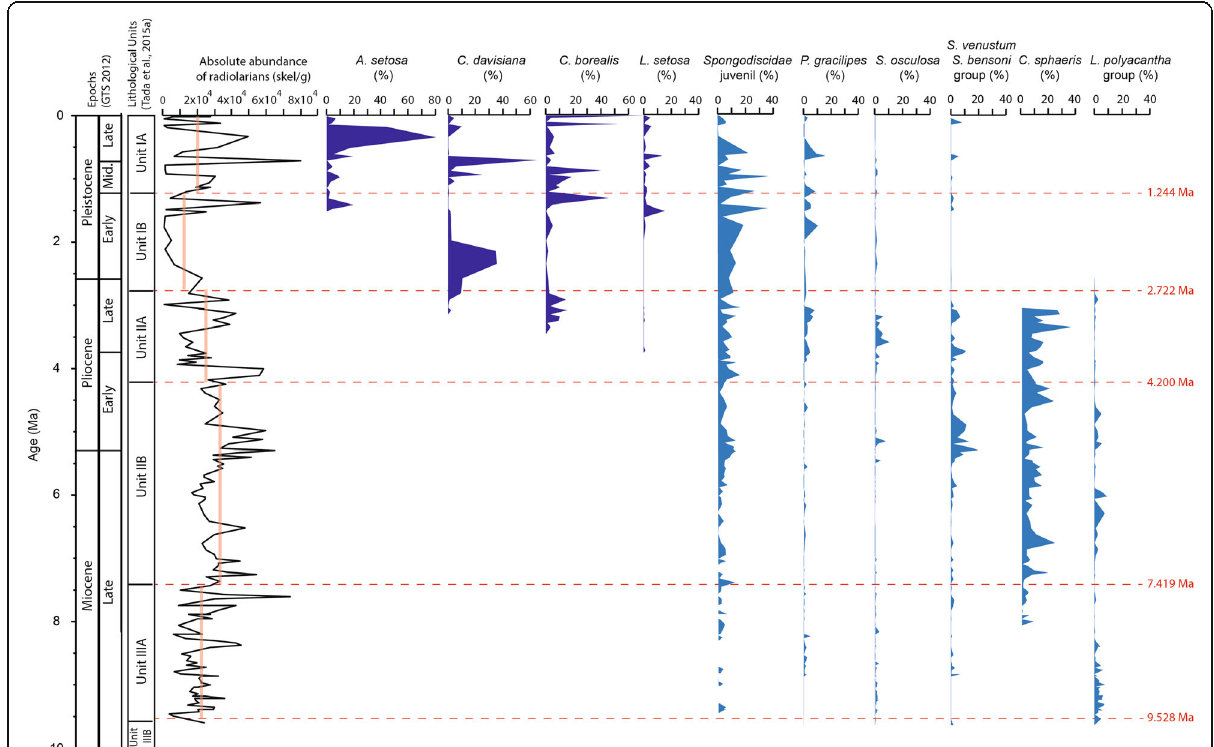
Fig. 3 Radiolarian absolute abundance (AB) (skel/g) and relative abundance (%) of selected radiolarian species (1/2) at Site U1425 plotted by age (Ma) (Kamikuri et al. 2017 depth age model) and compared to the lithological units of Tada et al. (2015a). Narrow red shading on the AB curve corresponds to the mean AB for each lithological